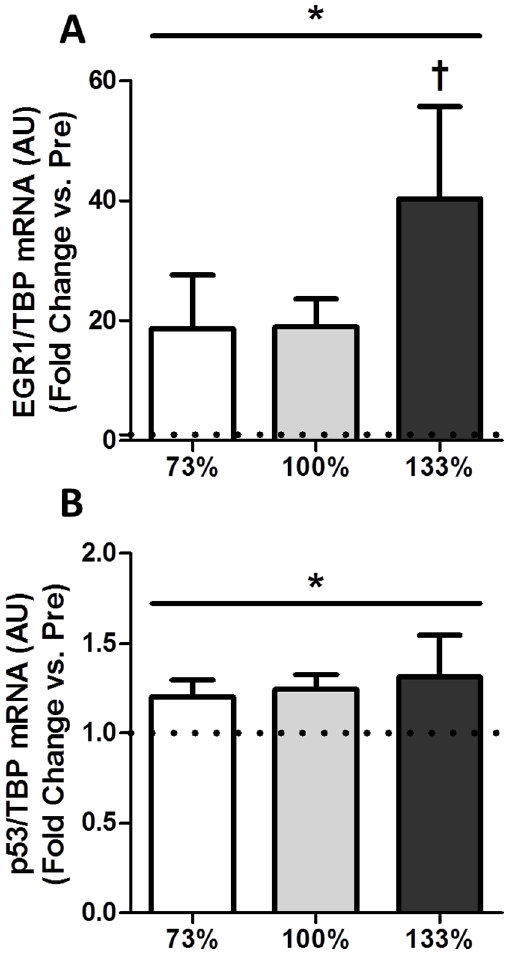
Figure 4. Impact of interval intensity on the expression of EGR1 and p53. Impact of interval intensity on the expression of (A) EGR1 and (B) p53. The change in mRNA expression from baseline to post-exercise for interval intensities of 73% (open bars), 100% (grey bars) and 133% (dark bars) is shown (A). Values presented as Mean 6 SEM. * Significant ( p , 0.05) main effect of time. { Significantly ( p , 0.05) different than other exercise intensities.